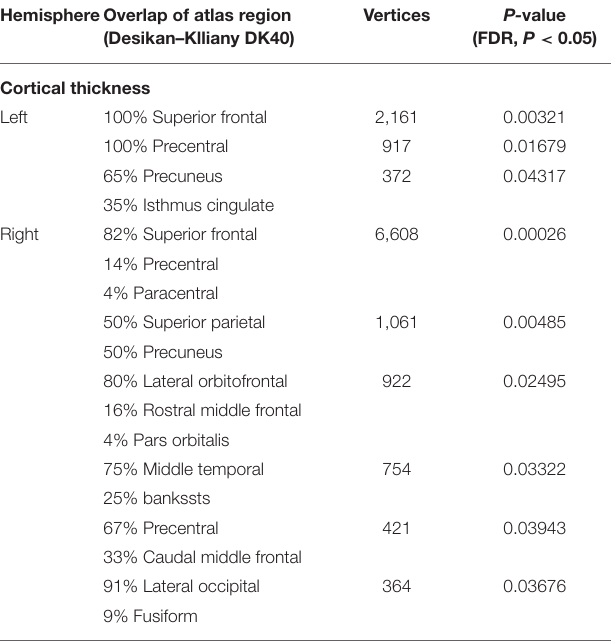
Vertices P- value (FDR, P <